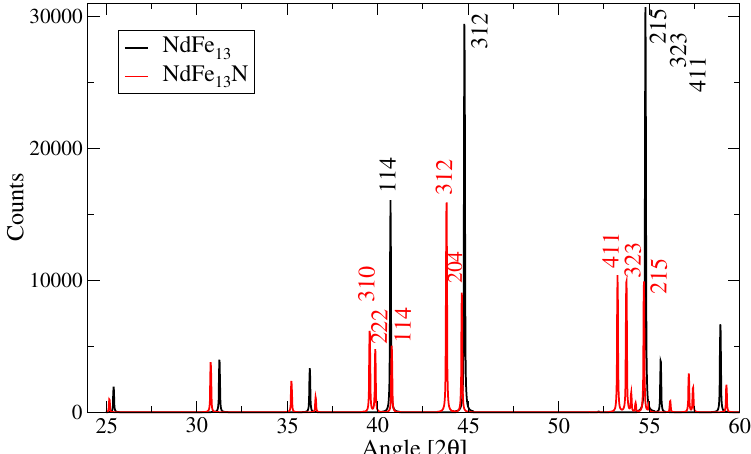
Figure 2. (Color online) Comparison of the diffraction patterns of NdFe 13 und NdFe 13 N calculated for a cobalt cathode with PowderCell 2.4 [40]. The peaks 215, 323, and 411 of NdFe 13 lie on top of the 215 peak of NdFe 13 N. The angles and amplitudes can be found in Table